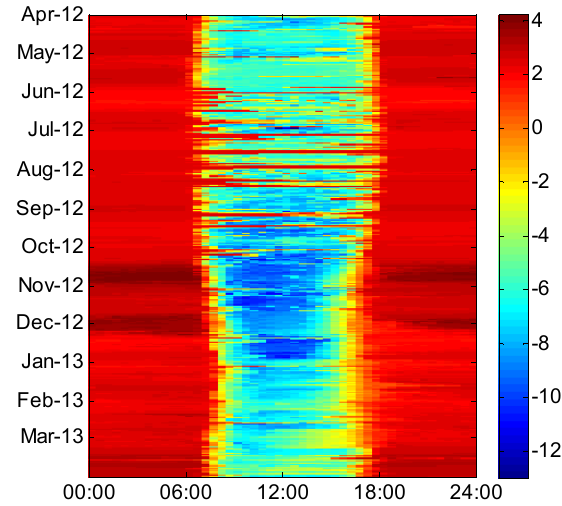
Figure 6. Monthly mean diurnal variation of half ‐ hourly CO 2 flux during April 2012 to March 2013. The error bars show one standard deviation of the diurnal average fluxes during respective months.